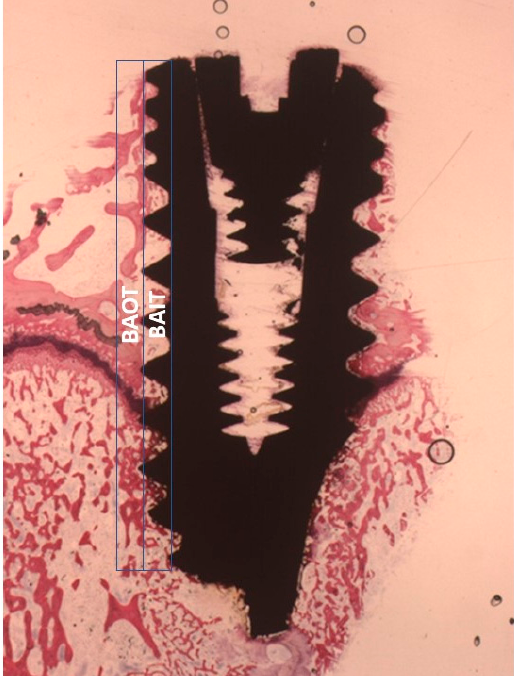
Figure 12. The area directly adjacent to the dental implant was evaluated within the thread part (BAIT), whereas the area far from the implant extended for the same size into the adjacent new/old bone (BAOT).